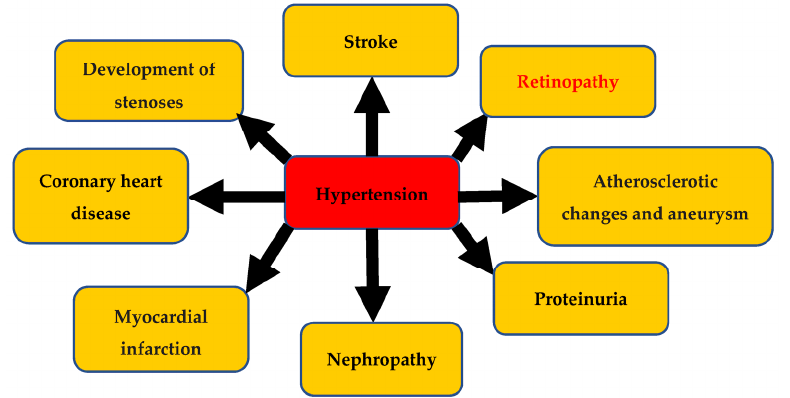
Figure 1. Prognosis of uncontrolled hypertension can lead to major organ damage such as ischemic and hemorrhagic stroke; coronary heart disease (CHD) with myocardial infarction (MI), proteinuria, and renal failure; and retinopathy and atherosclerotic changes, including the development of stenoses and aneurysms [4] (redrawn by using word).